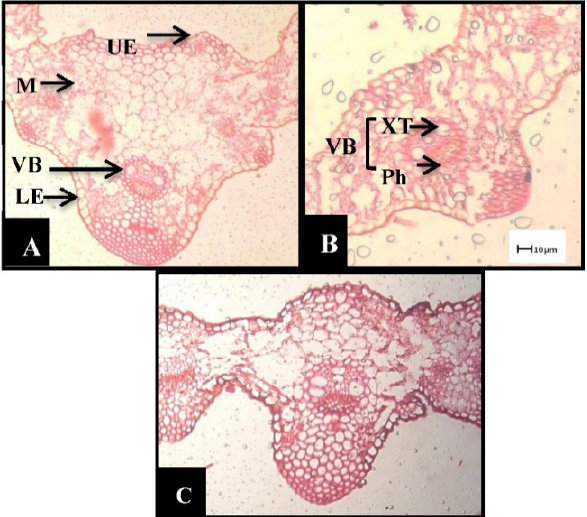
Figure 1. Effects of drought on barley leaves (transverse sections). ( A ) Control. ( B ) Plants irrigated once (D1), ( C ) plants irrigated twice (D2) (X 200). UE: upper epidermis, MT: mesophyll tissue, VB: vascular bundles, LE: lower epidermis, XT: xylem tissue, PhT: phloem tissue. (Hafez et al.